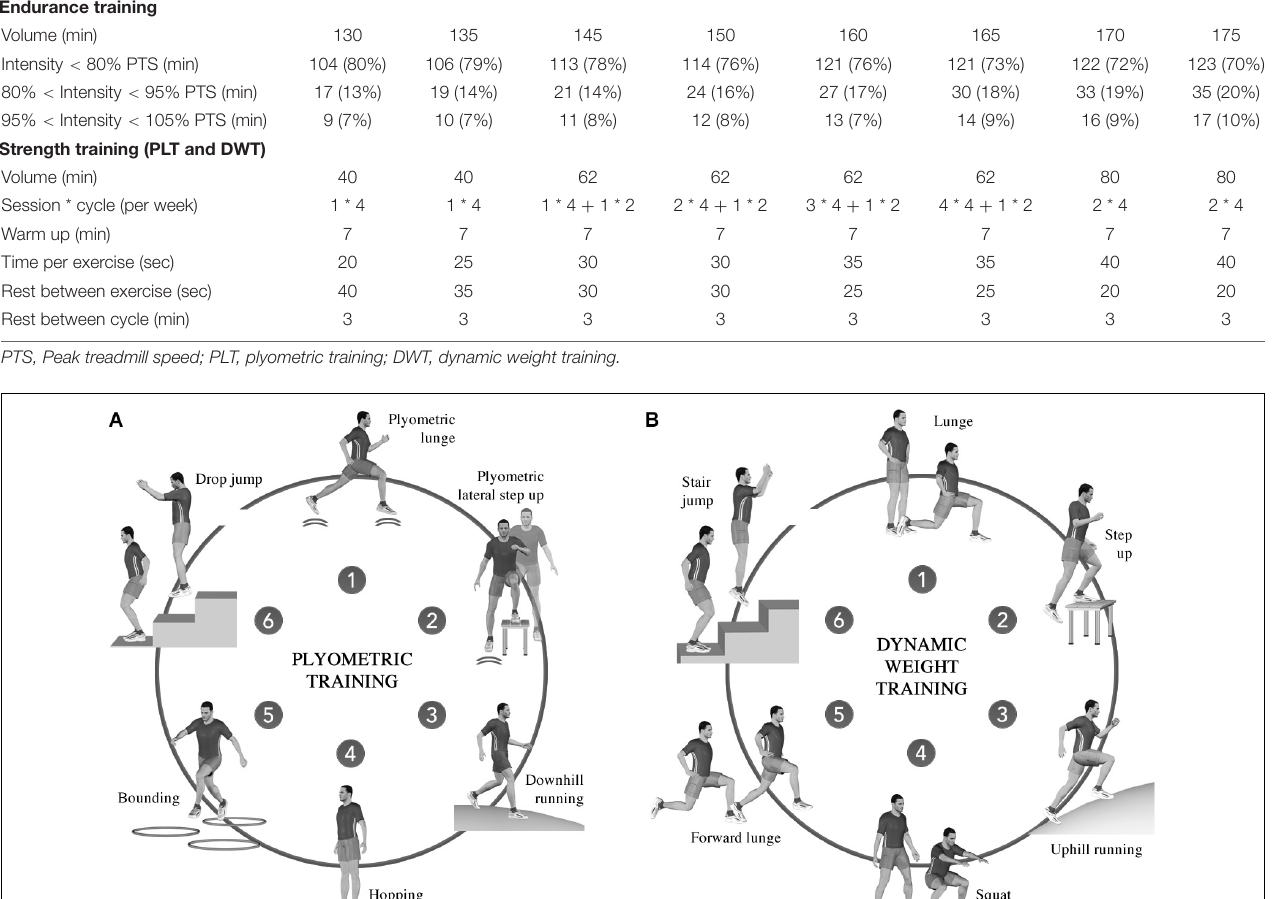
All jumps were performed with hands placed on the hips and participants were wearing their habitual running shoes. After five practice trials of each jump, three repetitions of each jump test were performed with a 30 s rest between repetitions and a 2 min rest between the SJ and 5RJ tests. The best repetition of the SJ (based on the longest t f ) and 5RJ (based on the highest average mechanical power) was used for statistical